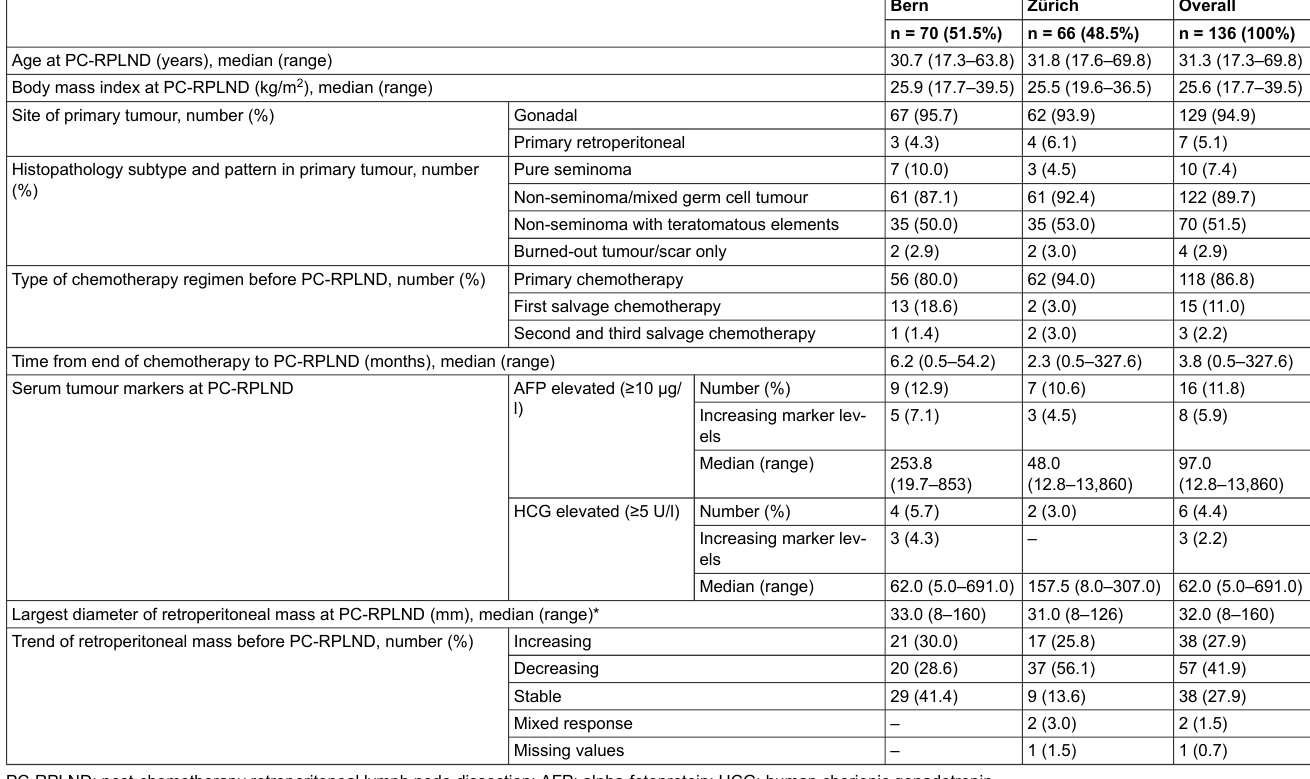
Table 1: Patients’ baseline and preoperative